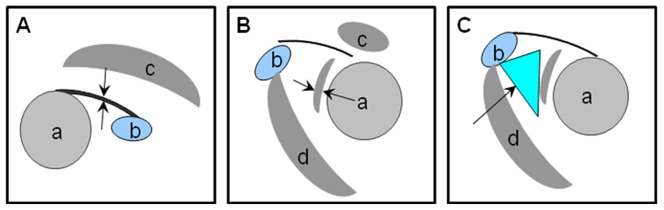
Measurement Scheme.(A) Thickest portion of CHL on sagittal oblique T1-weighted spin-echo images was measured (arrowheads). a, caput humeri, b, coracoid notch, c, supraspinatus muscle. (B) Capsular thickness (arrow) in rotator cuff interval was measured on sagittal oblique T1-weighted spin-echo images. Thickest portion of capsule (arrow) perpendicular to surface of humeral head was measured along a radial line drawn to center of humeral head. a, caput humeri, b, coracoid notch, c, supraspinatus muscle, d, coracobrachial muscle. (C) Sagittal oblique T1-weighted image of subcoracoid fat triangle. Borders of the triangle (arrow) are defined anterosuperiorly by the coracoid process (C), superiorly by the CHL (arrow), and posteroinferiorly by the joint capsule. a, caput humeri, b, coracoid notch, d, coracobrachial muscle.